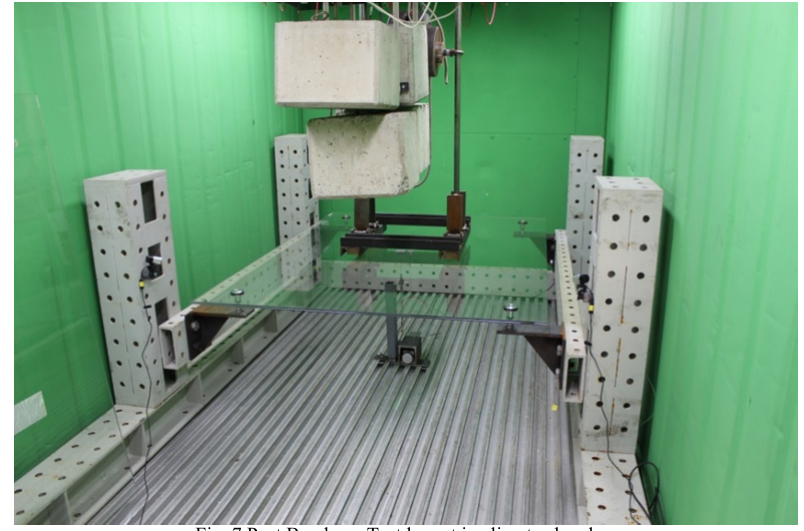
Fig. 7 Post Breakage Test layout in climate chamber